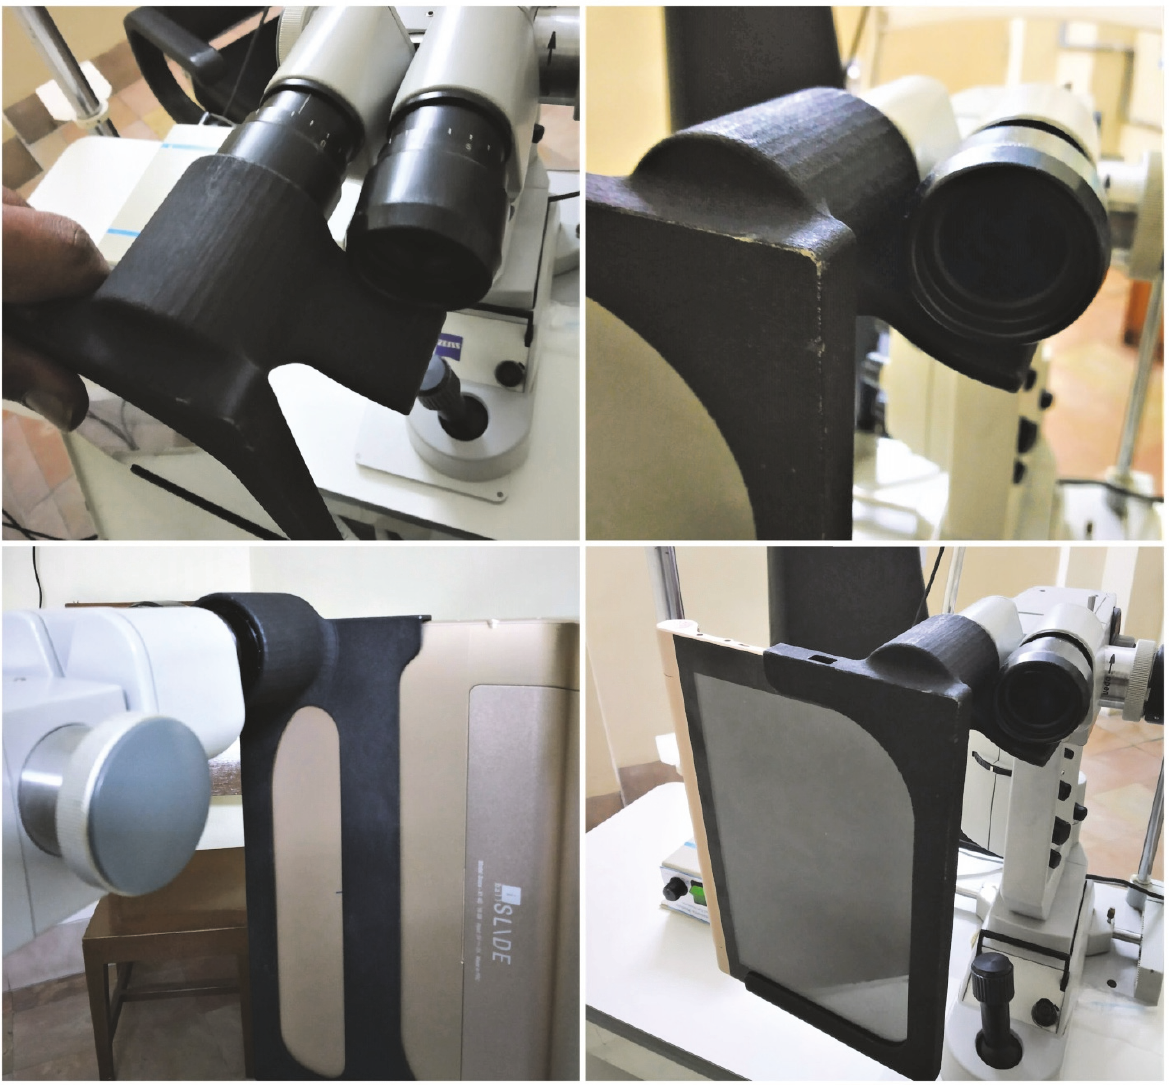
Figure 9: Cyclops attachment with the tablet on the slit